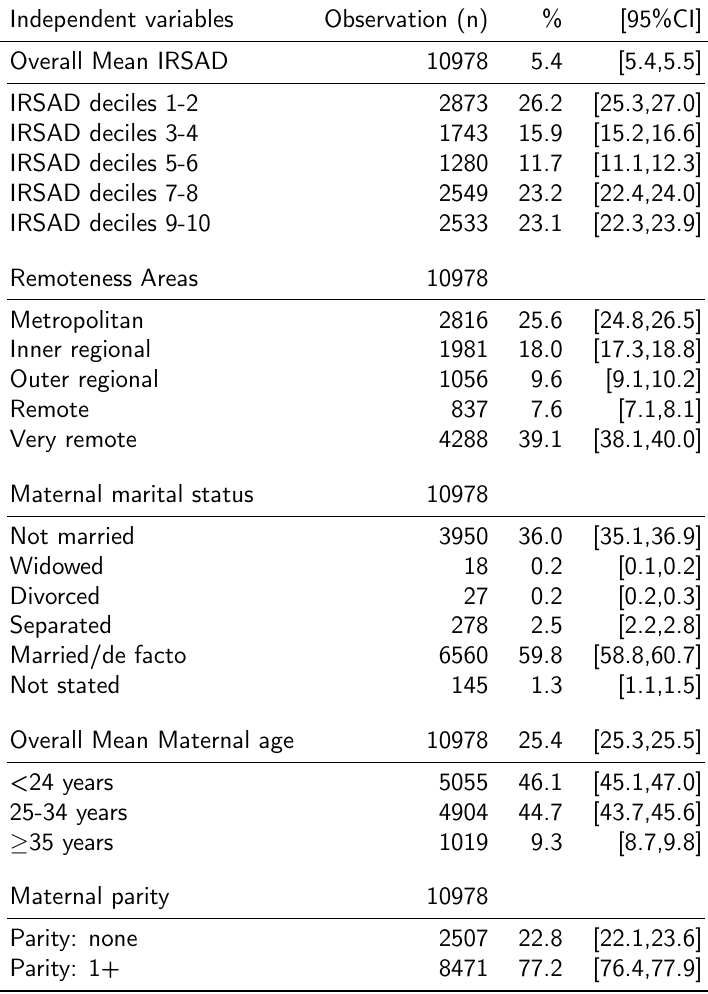
Table 1: Prevalence of maternal mental health contacts in the 5 years prior to birth, by selected